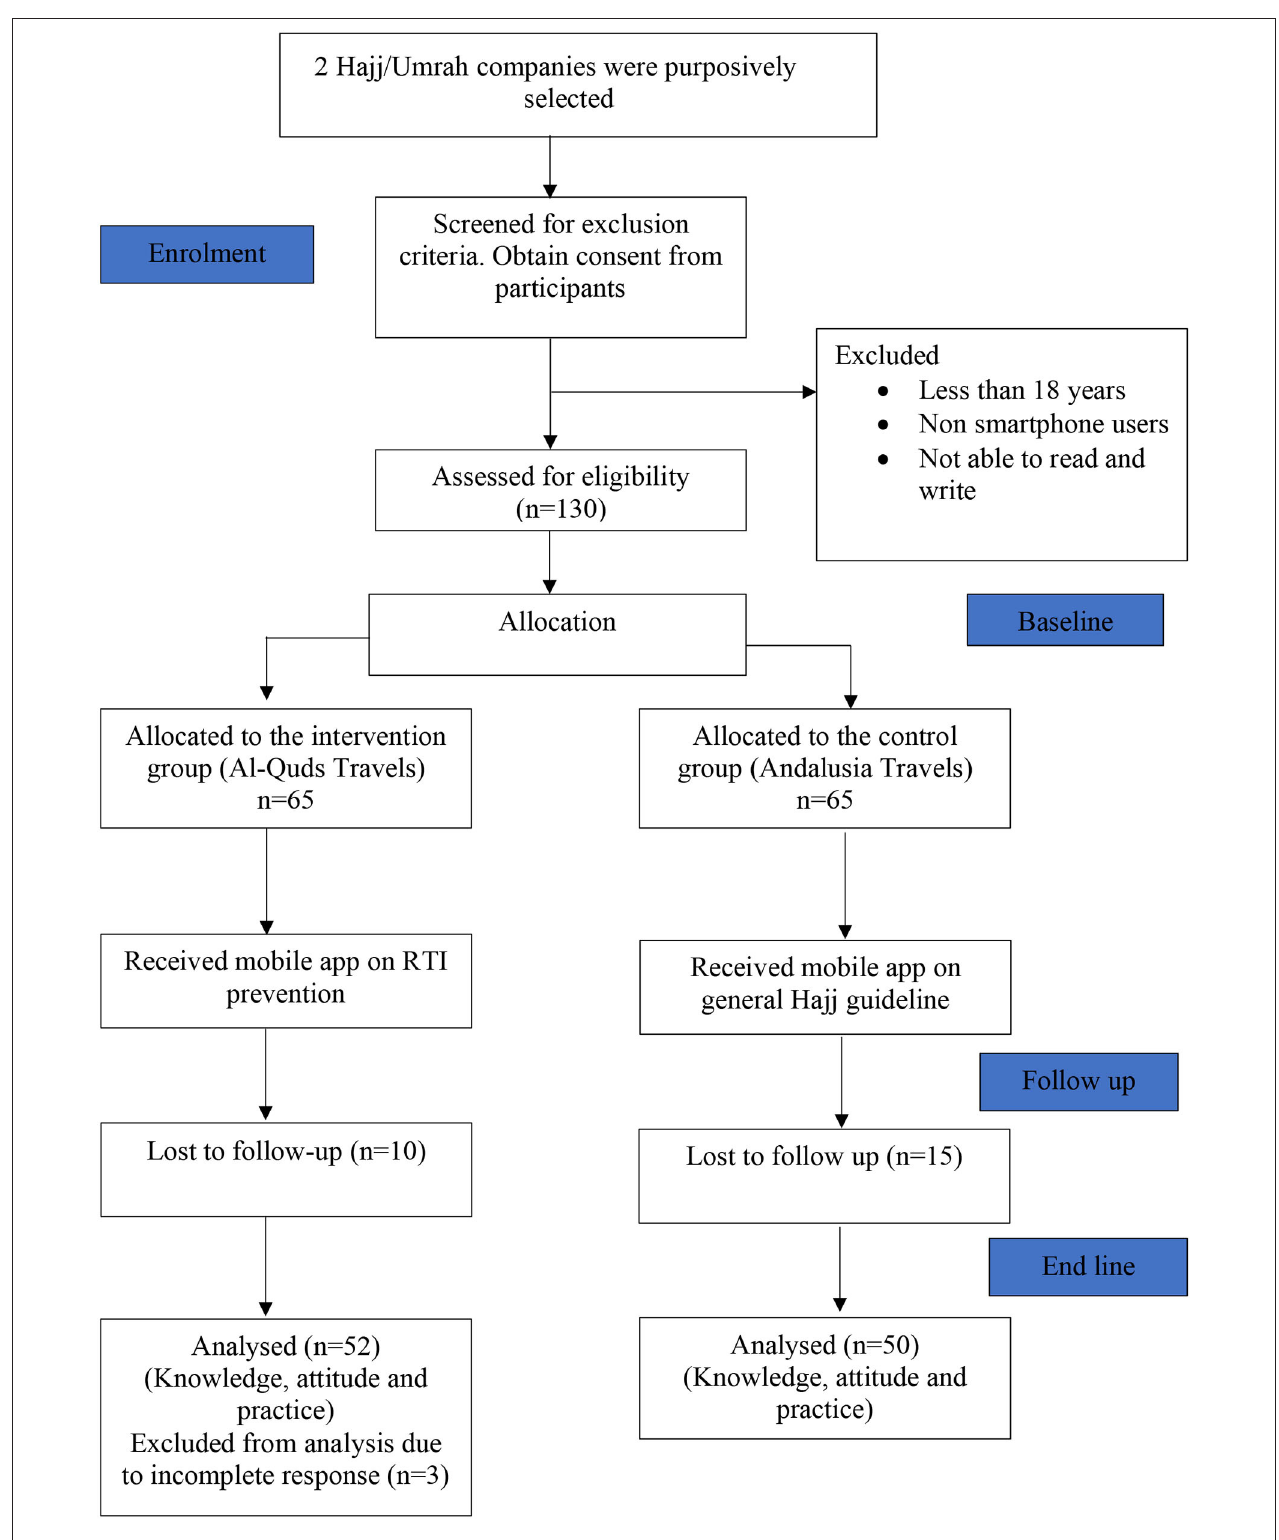
FIGURE 1 | Flow chart of respondents in a quasi-experimental study conducted among Hajj pilgrims in private Hajj companies from Kelantan, Malaysia.